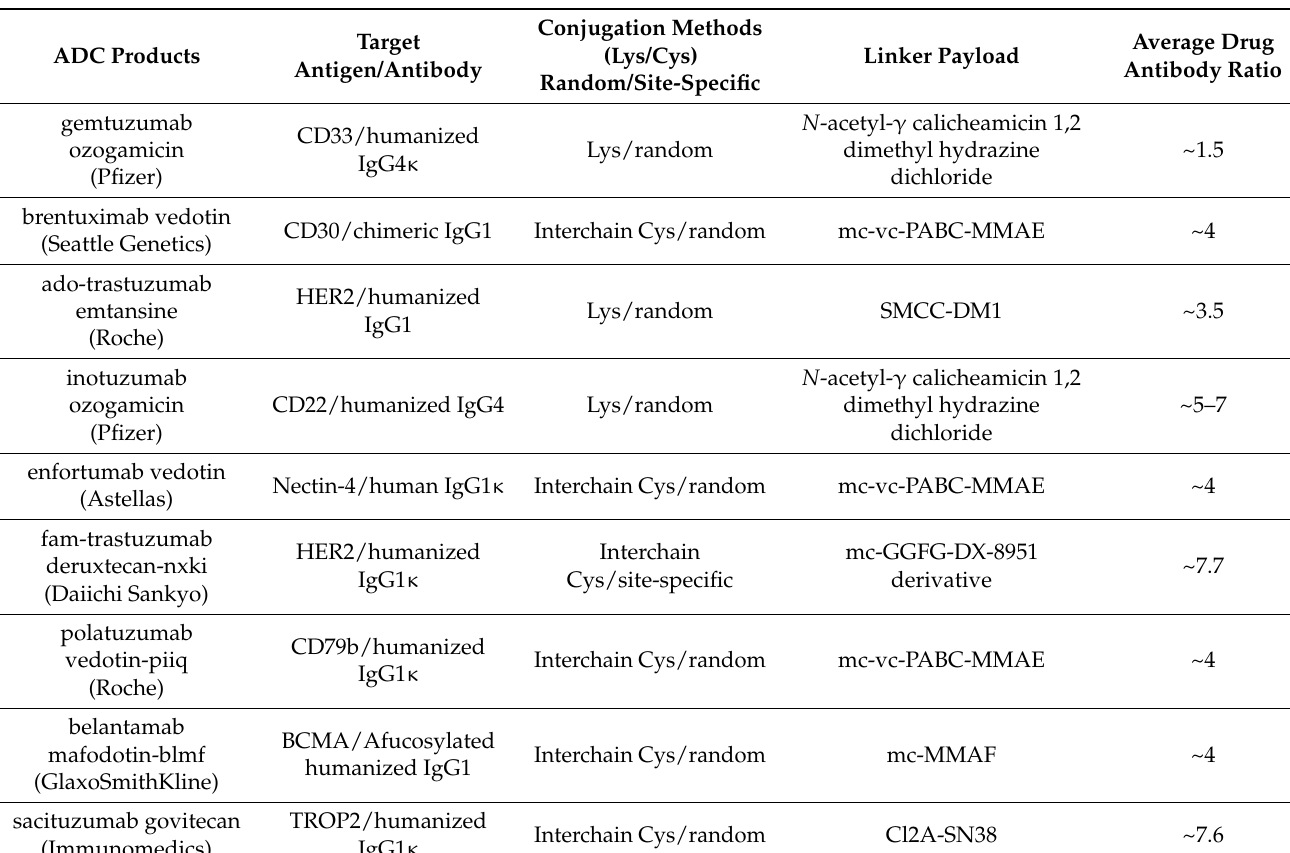
Table 4. Target antigens, antibody, conjugation methods, linkers, payloads, and average drug antibody ratio (DAR) of approved